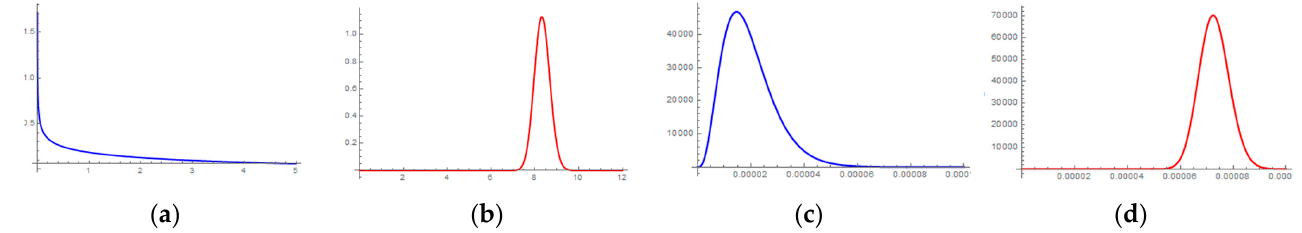
Figure 8. Specimen gamma (left) and beta (right) distributions. ( a ) α = 0.065, 1/ β = 62; ( b ) α = 0.489, 1/ β = 1337; ( c ) α = 4.11 β = 212688; ( d ) α = 163.19, β = 2239631. Meanwhile, although the beta distribution and analytical assay measurement error